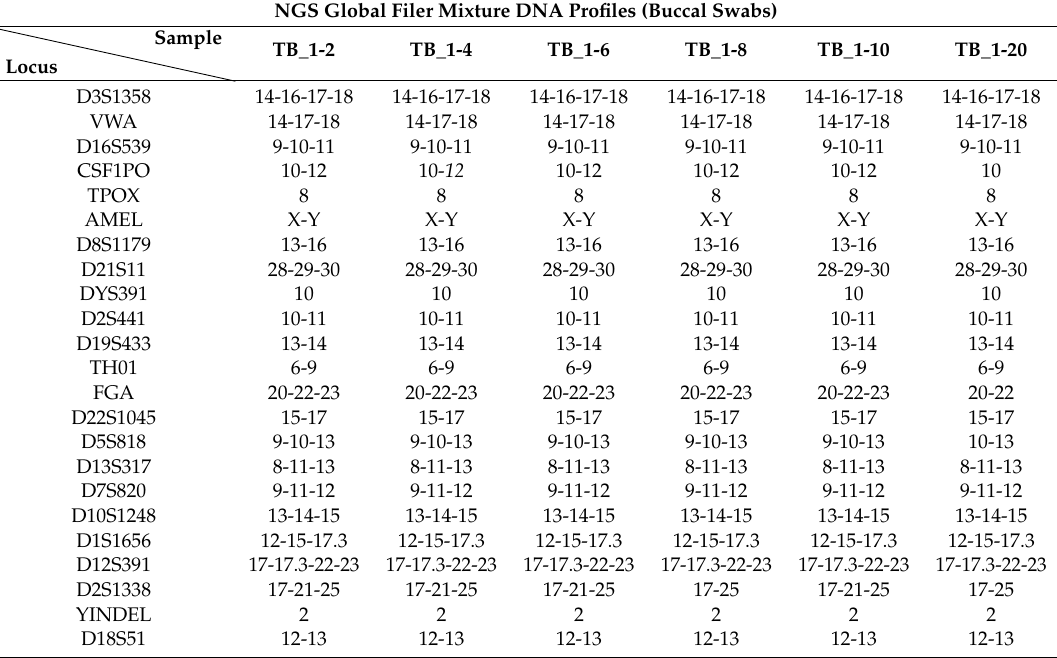
Table 3. Genotyping results for the buccal swab mixture samples. NGS: Next-Generation